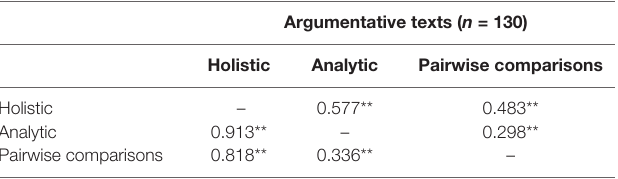
TABLE 8 | Correlation coefficients between holistic rating, analytic rating and pairwise comparisons.